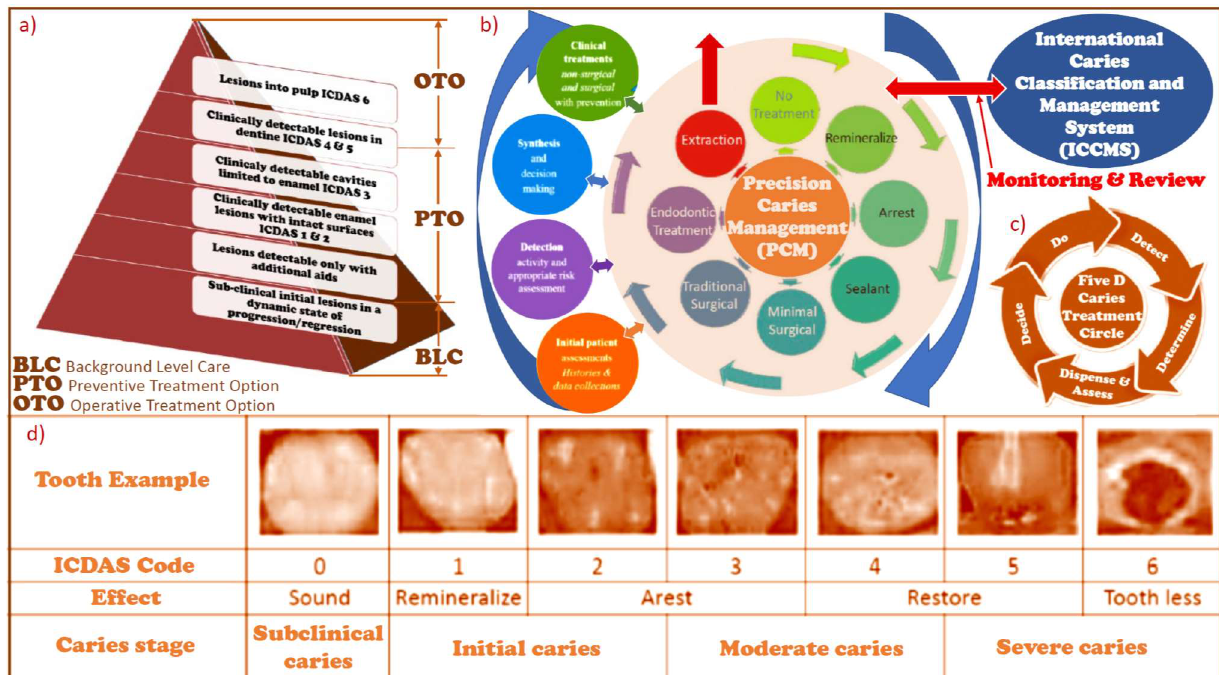
Figure 1. Diagram: ( a ) CDP caries development pyramid; ( b ) the Precision Caries Management (PCM) in cooperation with the International Caries Classification and Management System (ICCMS); ( c ) the 5D Caries Management Cycle Rules (CMCRs); ( d ) the International Caries Detection and Assessment System (ICDAS) application.